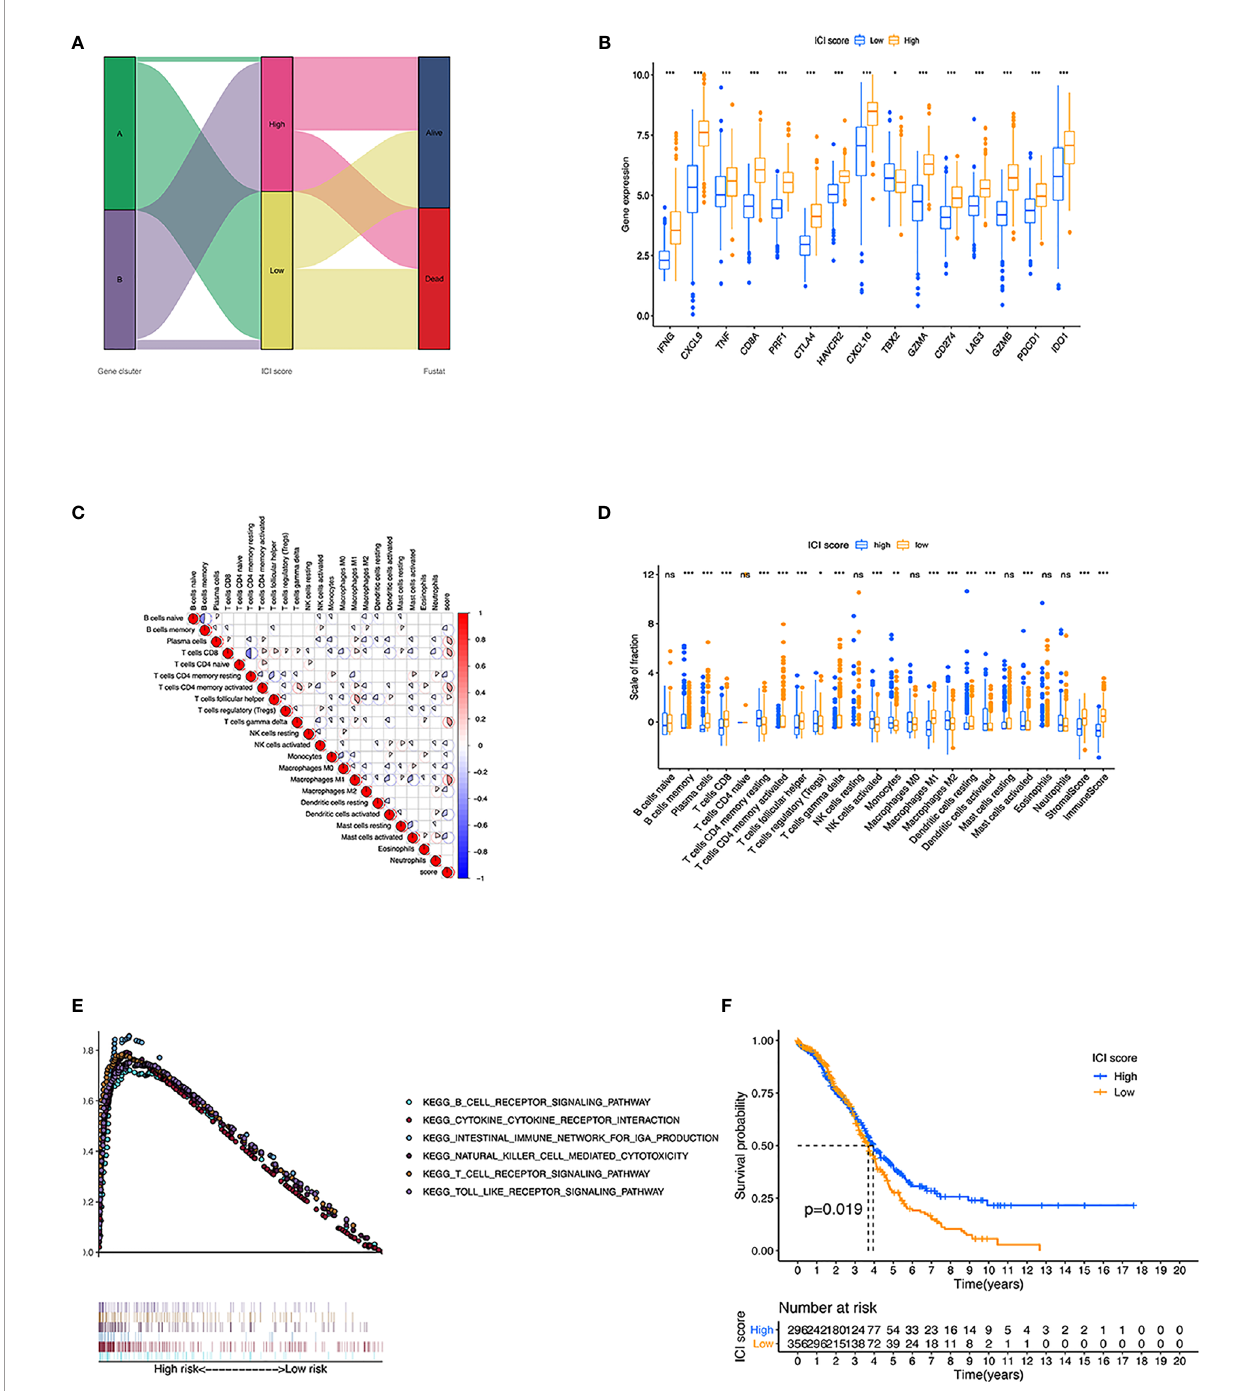
FIGURE 5 | Construction of ICI scores. (A) Alluvial diagram of ICI gene cluster distribution in groups regarding to different gene clusters, ICI scores, and survival status. (B) Immune-activity-related signatures and immune-checkpoint-relevant signatures in low and high ICI subgroups. (C) Interaction of immune cell in fi ltration and ICI score in two gene clusters. (D) Cellular fraction of the tumor-in fi ltrating immune cell types in high and low ICI, including Stromal Score and Immune Score. (E) Gene set enrichment plots showed the rich KEGG pathways in the high ICI subgroup. (F) Kaplan-Meier curves for high and low ICI groups in two OC cohort. * p < 0.05; ** p < 0.01; *** p < 0.001; ns, not signi fi